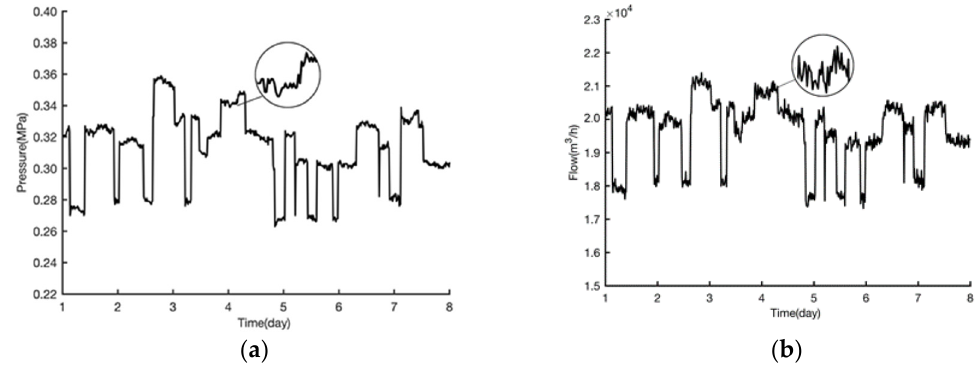
Figure 4. Pressure ( a ) and flow ( b ) at the pump station.